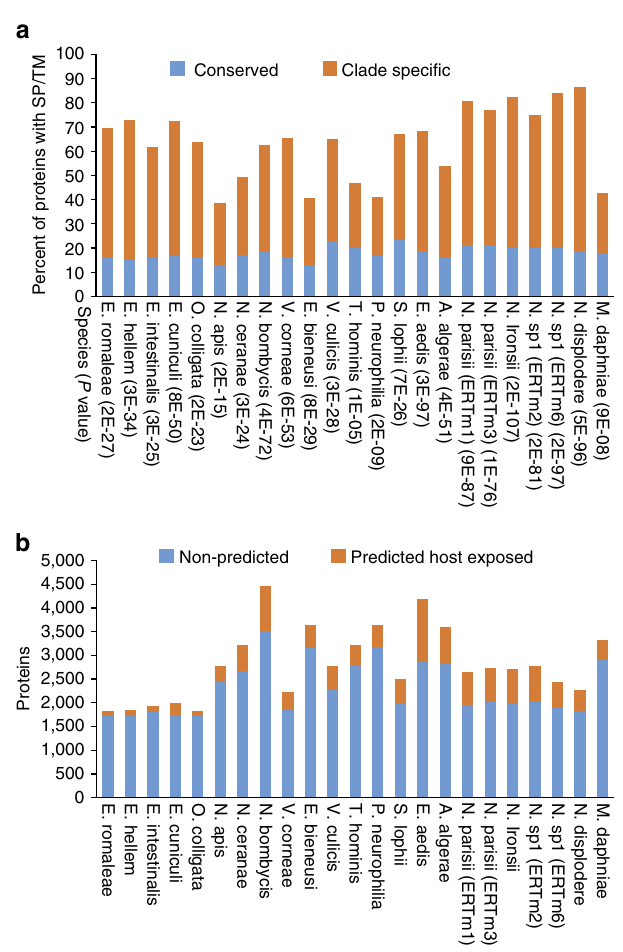
Figure 5 | Prediction of host-exposed microsporidia proteins. ( a ) Clade- specific microsporidia proteins (orange) are enriched in signal peptides/ transmembrane domains compared with conserved proteins (blue). Enrichment P -values (one-sided Fisher’s exact test) are listed in parenthesis below each species. ( b ) The number of proteins in each microsporidia genome that are predicted to be host-exposed proteins (orange), compared with the rest of the genome